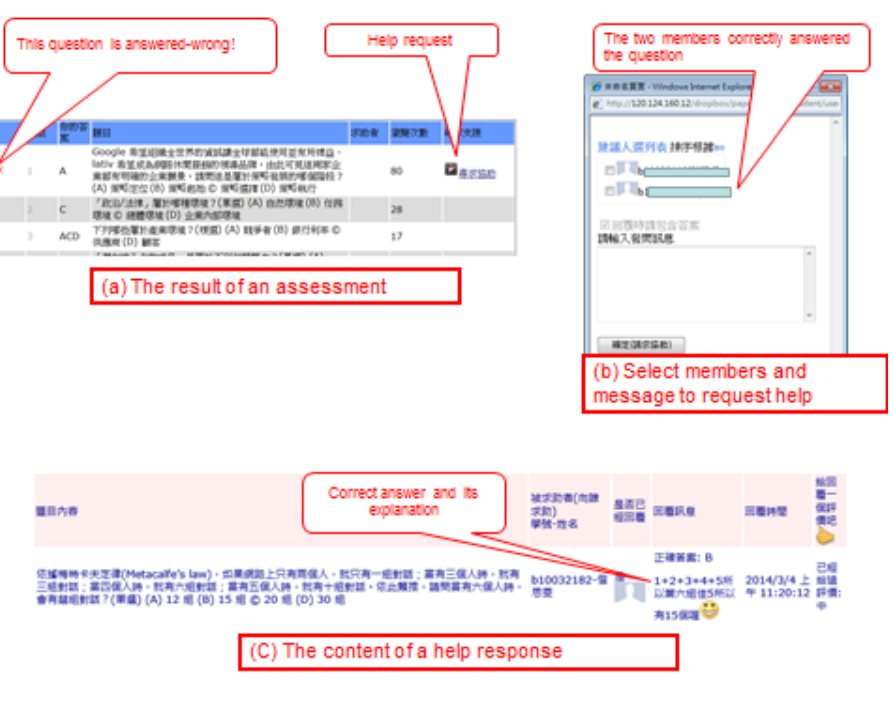
Figure 2. The functions for requesting help to members for both